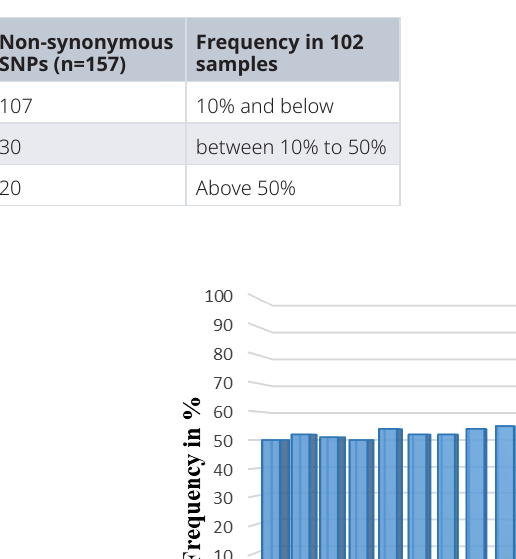
Table 3. Total observed non-synonymous SNPs in the sequenced data after read cleaning, multiple sequence alignment, intron deletion and conversion to protein sequences. The total number of SNPs was 157 across the entire protein length, in all the 102 sequenced samples. 107 SNPs were only overserved in 1-10% of the samples and were excluded. 30 of the remaining SNPs occurred in 10-50% samples and this frequency was not high enough to be considered for downstream analysis, they were excluded as well. The final 20 codons of the total observed non-synonymous SNPS had a frequency >50% of the total samples sequenced. These were considered for protein structure analysis. The frequency was high thus the implications of these SNPs was analyzed further.